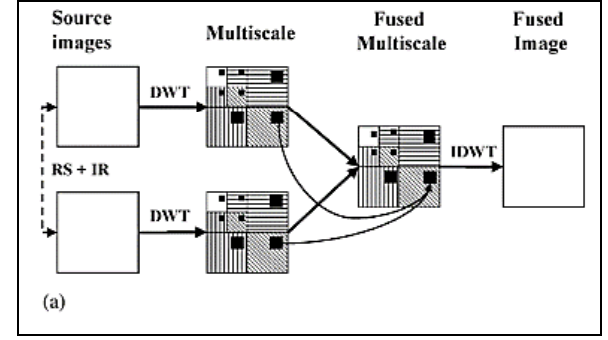
Figure 2. Wavelet based image